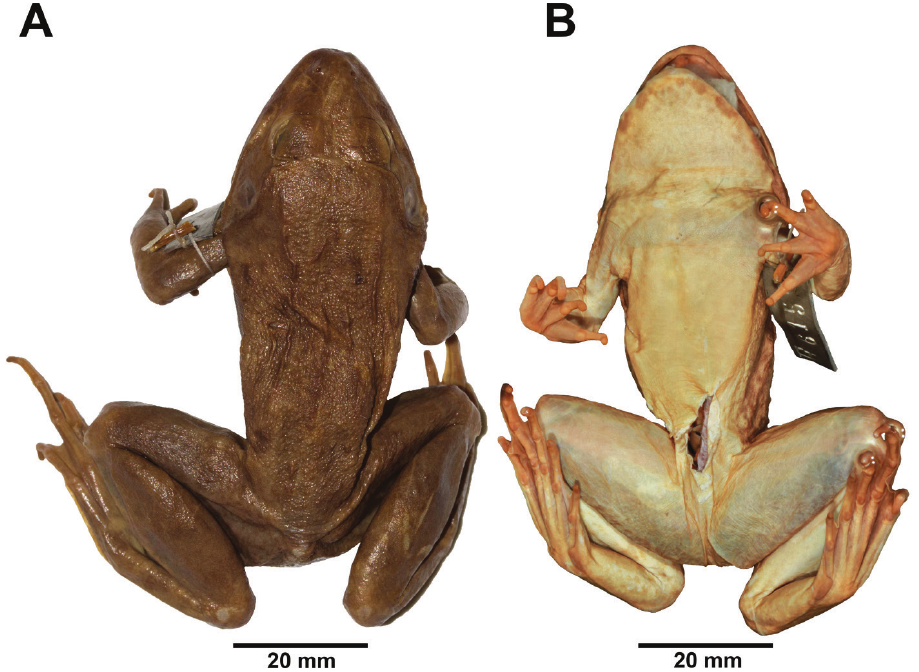
Figure 8. Adult female holotype of Fejervarya moodiei (CM 3724) in preservative in A dorsal and B ventral views. Photograph B by Carnegie Museum of Natural